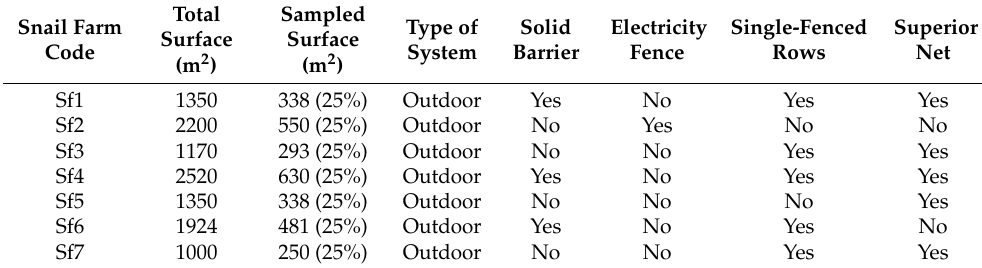
Table 1. Baseline characteristics of the seven involved